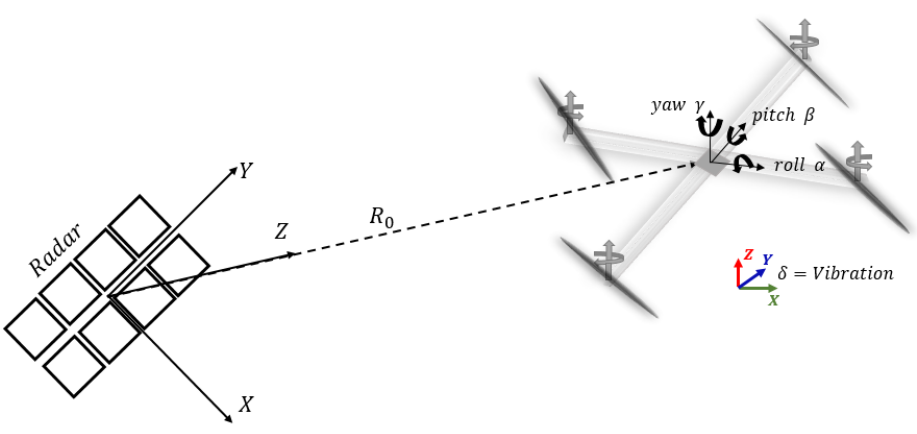
Figure 1. Geometry of the radar and rotor blades of an unmanned aerial vehicle (UAV) and their vibration angle